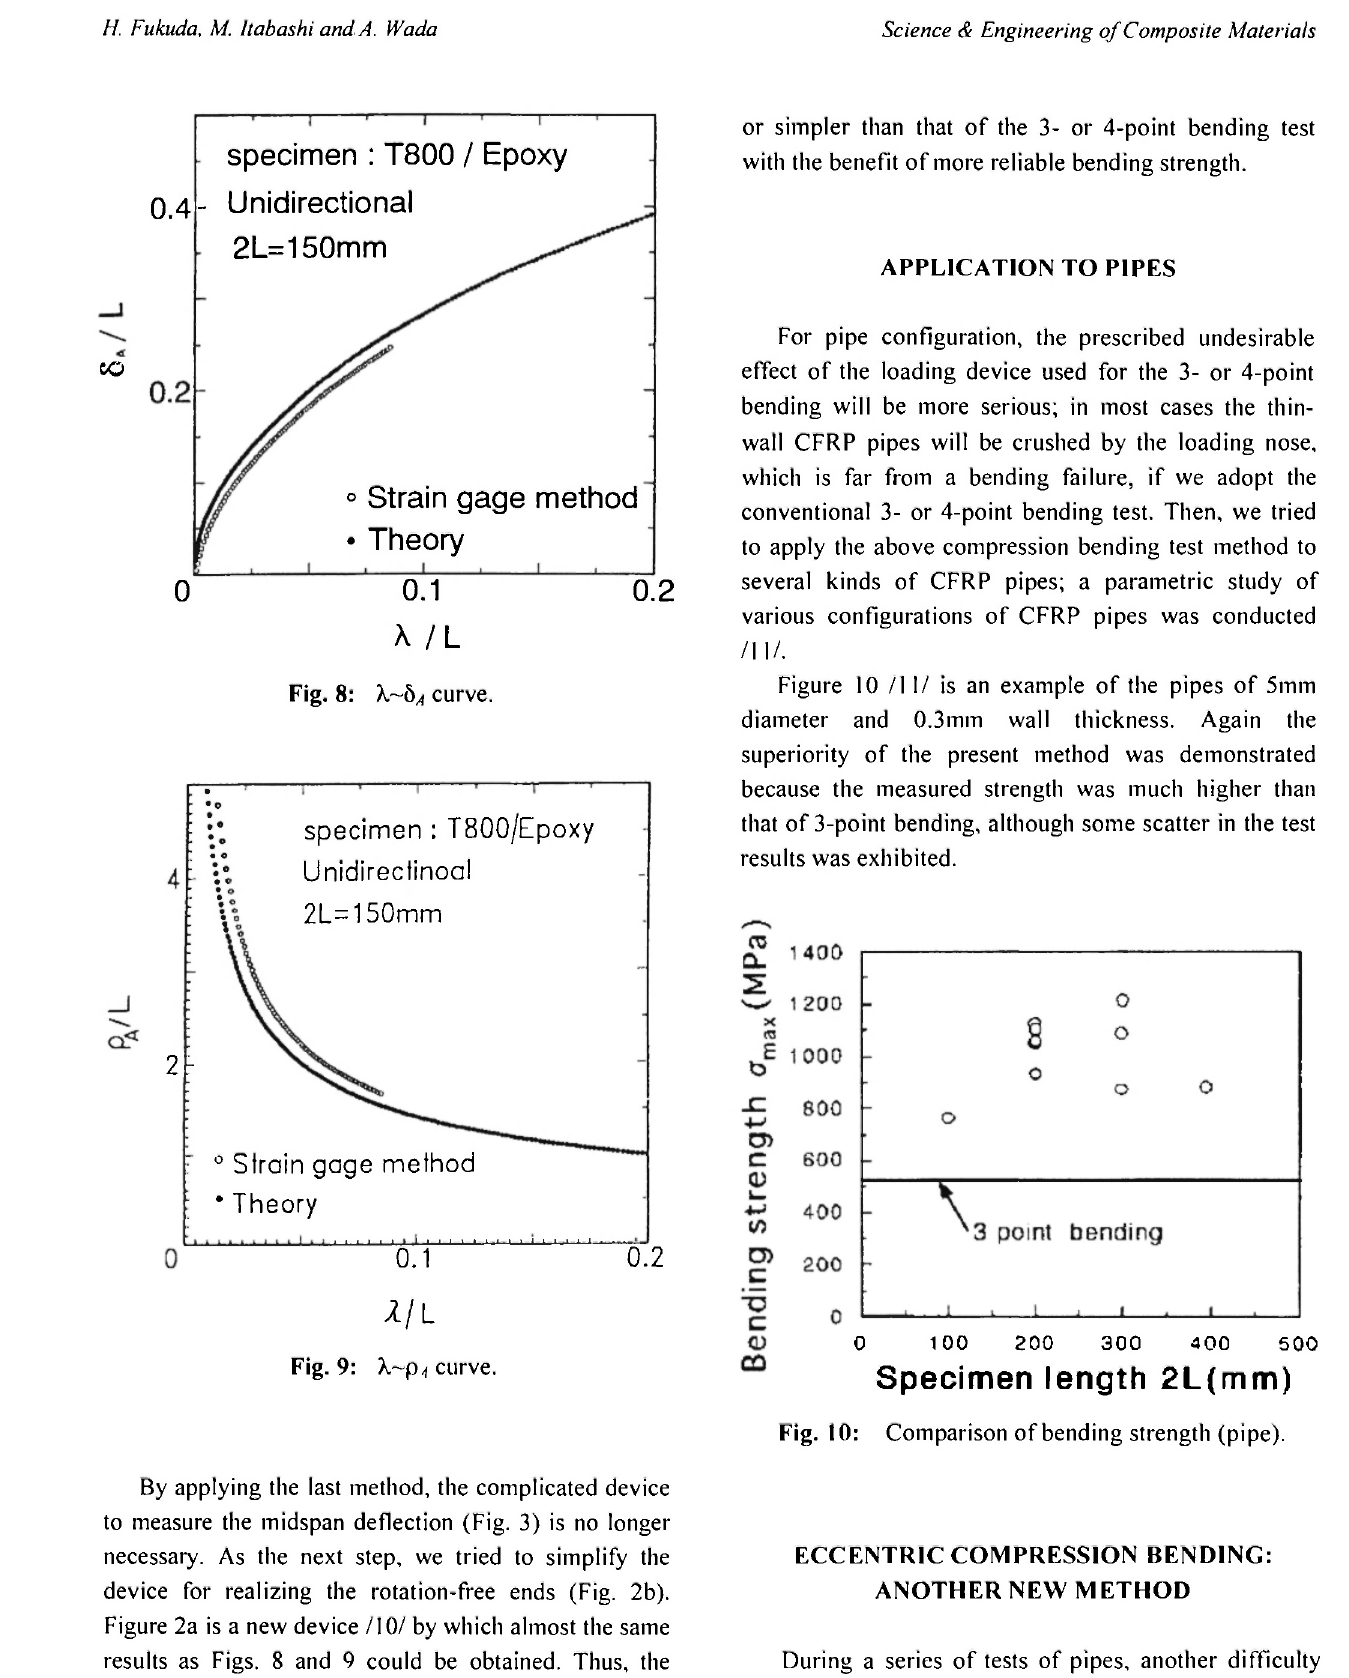
Fig. 10: Comparison of bending strength